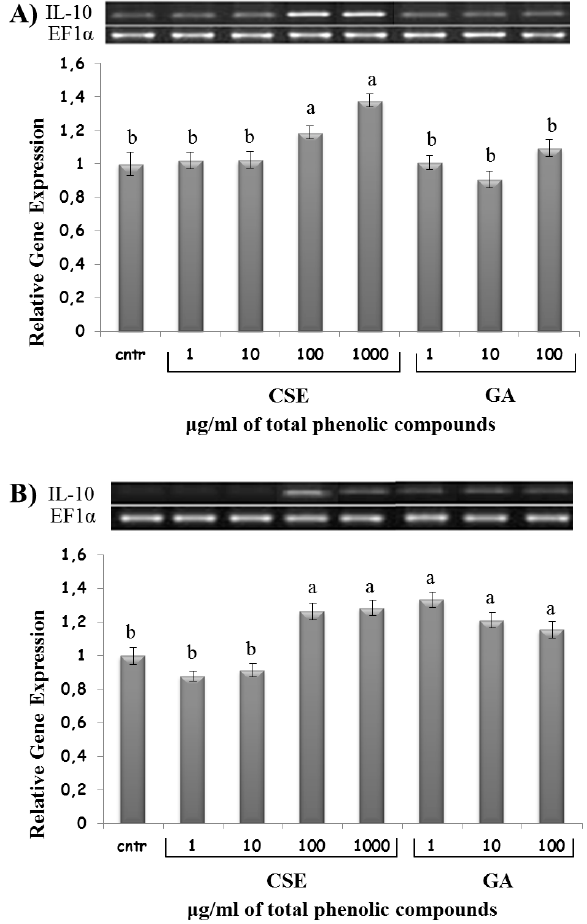
Figure 9. IL-10 mRNA expression in response to different doses of CSE and GA in in vitro incubations of intestinal intraepithelial non-adherent leukocytes ( A ) and blood non-adherent leukocytes ( B ) of rainbow trout. The data represent the mean ± SD of different fish samples ( n = 9). Different letters on the columns indicate statistically significant differences (cntr = control). The housekeeping gene was EF1 α . The concentration reported on the x axis refers to the total phenolic compounds contained in the chestnut shell extract (CSE).